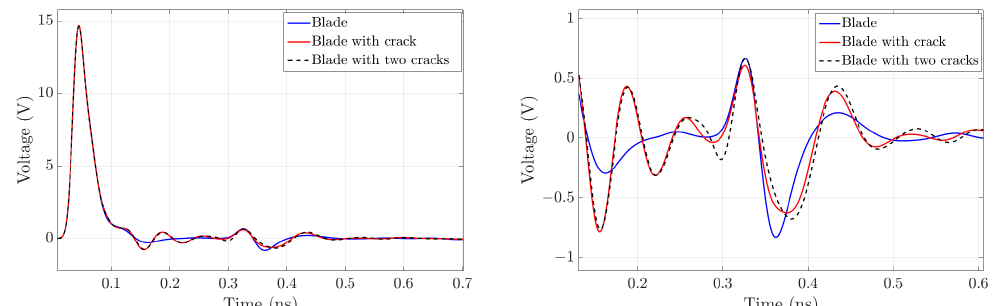
Figure 8. Comparison between the reflected voltage in the three different simple